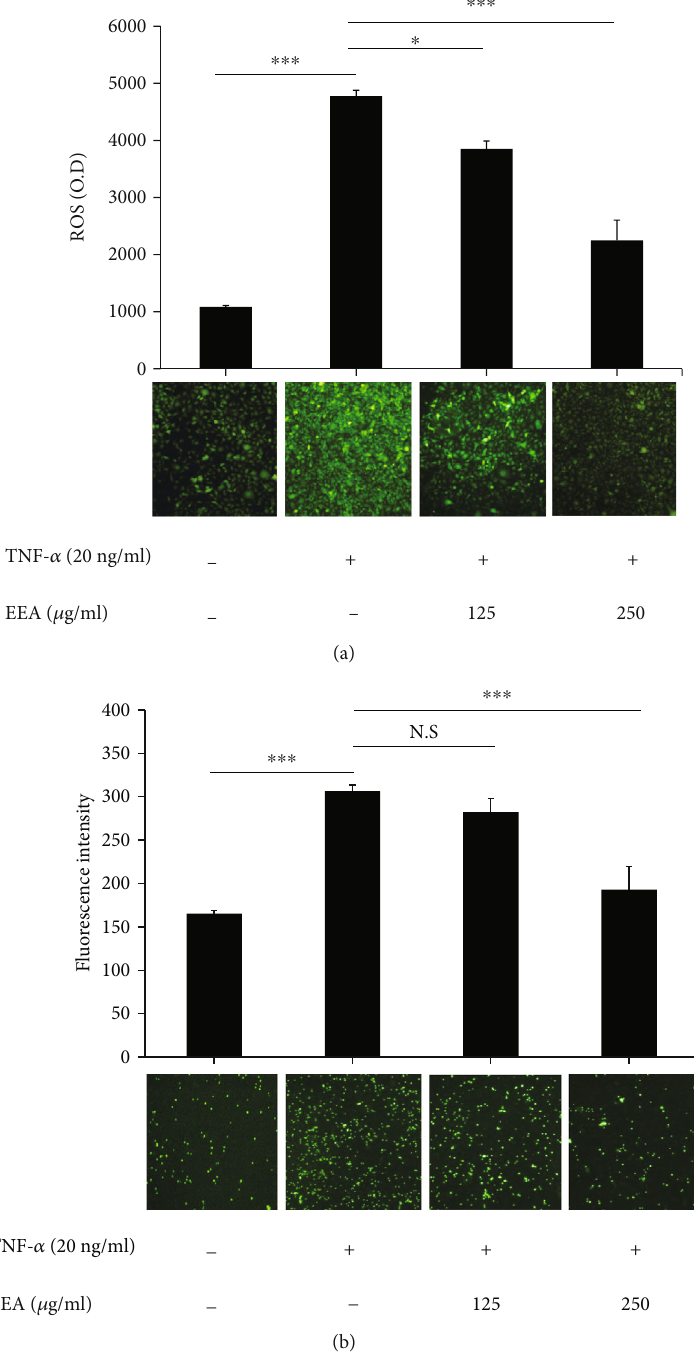
Figure 2: EEA reduces TNF- α -stimulated ROS production and PBMC adhesion to HUVECs. Target cells were incubated with two concentrations of EEA (125 and 250 μ g/ml) for 6h, followed by treatment along with TNF- α (20 ng/ml) for 12h. (a) DCFH-DA probes assessed ROS production. Fluorescent microscopy showed decreased ROS production in Assafoetida pretreatment. (b) The adhesive function of PBMCs for HUVECs was assessed. Fluorescent microscopy showed decreased adhesion in EEA pretreatment. The data re fl ects the mean ± SD ( N = 3 ). ∗ p < 0 : 01 and ∗∗∗ p < 0 : 0001 opposed to control and TNF- α -treated groups. N. S: not signi fi